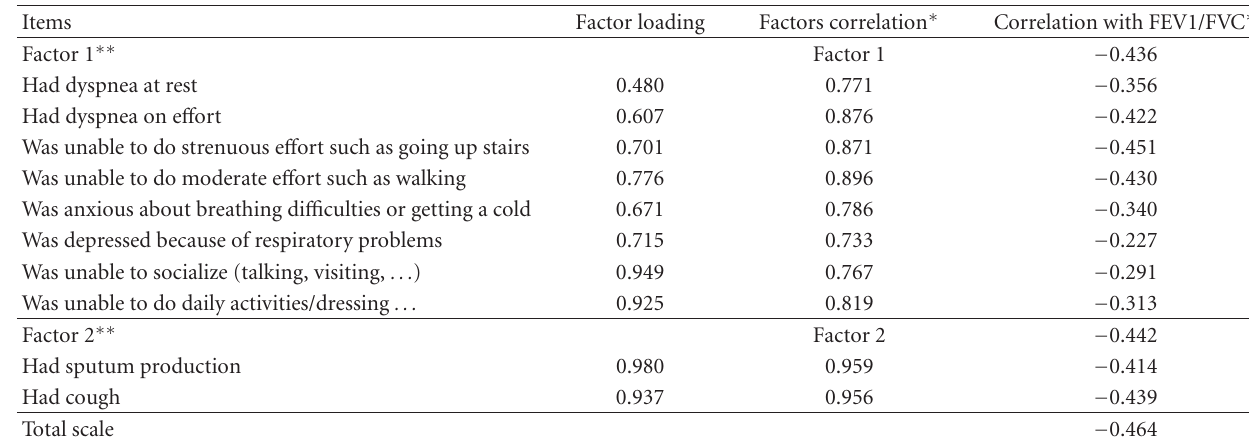
Table 2: Factorial analysis of the Clinical COPD